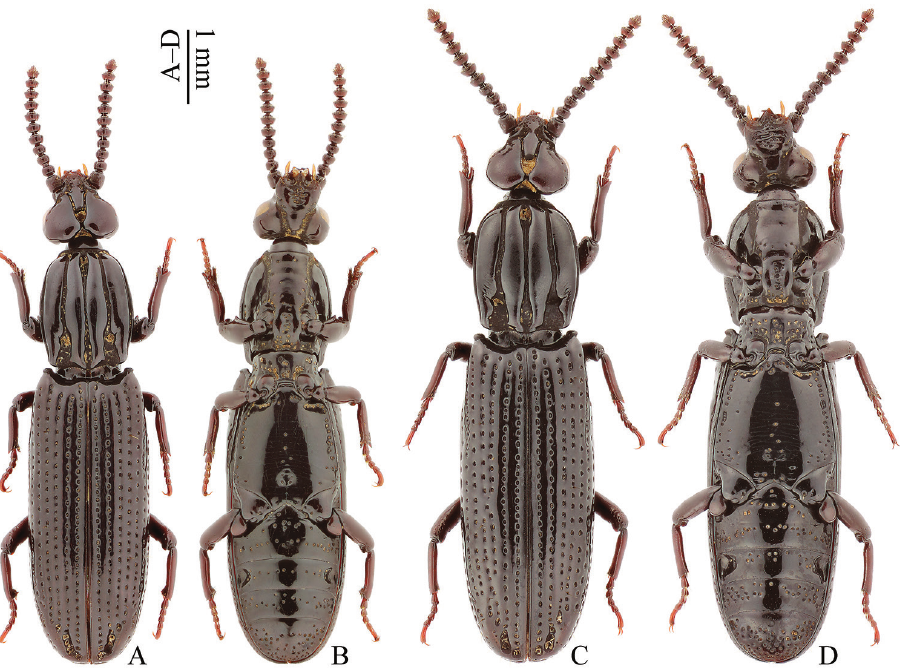
Figure 2. Habitus of Omoglymmius ( s. str. ) wukong sp. n. ( A–B holotype ♂ C–D paratype ♀ ). ( A, C dorsal view B, D ventral